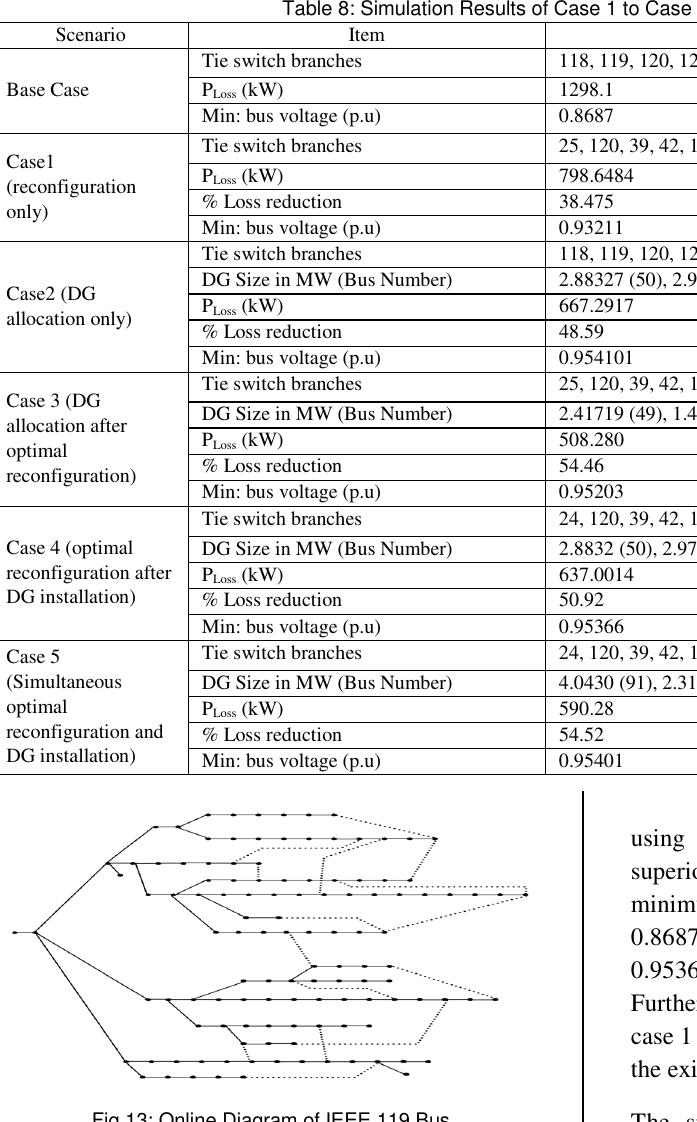
Fig 13: Online Diagram of IEEE 119 Bus Table 7: Loops of 119 Bus Test System